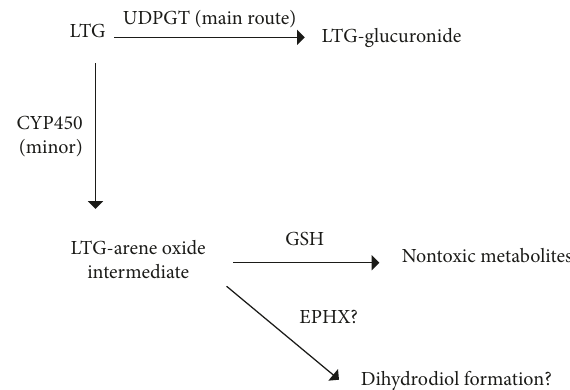
Figure 1: Metabolism pathways of lamotrigine. UDPGT: uridine diphosphate glucuronosyltransferase; EPHX: epoxide hydrolase; GSH: